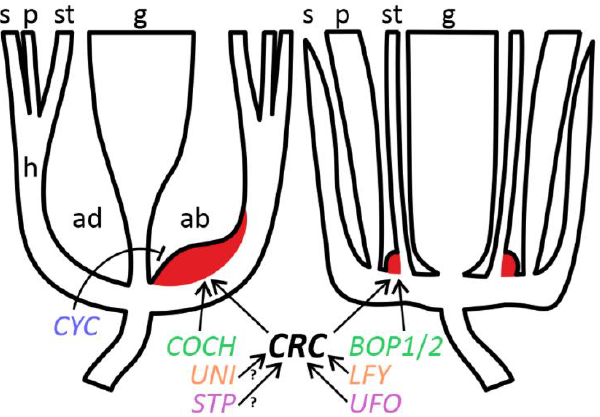
Figure 7. Schematic representation of floral morphology and regulation of FN development comparing Pisum (left) and Arabidopsis (right). Orthologous genes are designated with the same color. Key: arrow = positive regulation; blunt arrow = negative regulation; red color = FN; ab = abaxial floral domain; ad = adaxial floral domain; g = gynoecium; h = hypanthium; p = petals; s = sepals; st = stamens; ? = hypothetical pathway.